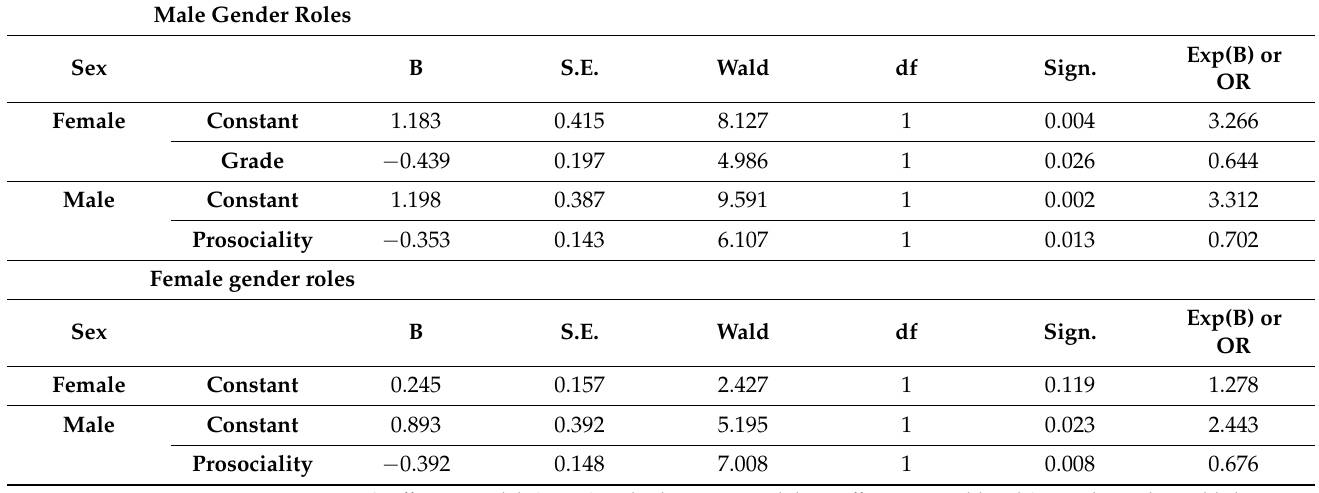
Table 1. Results of binary logistic regression